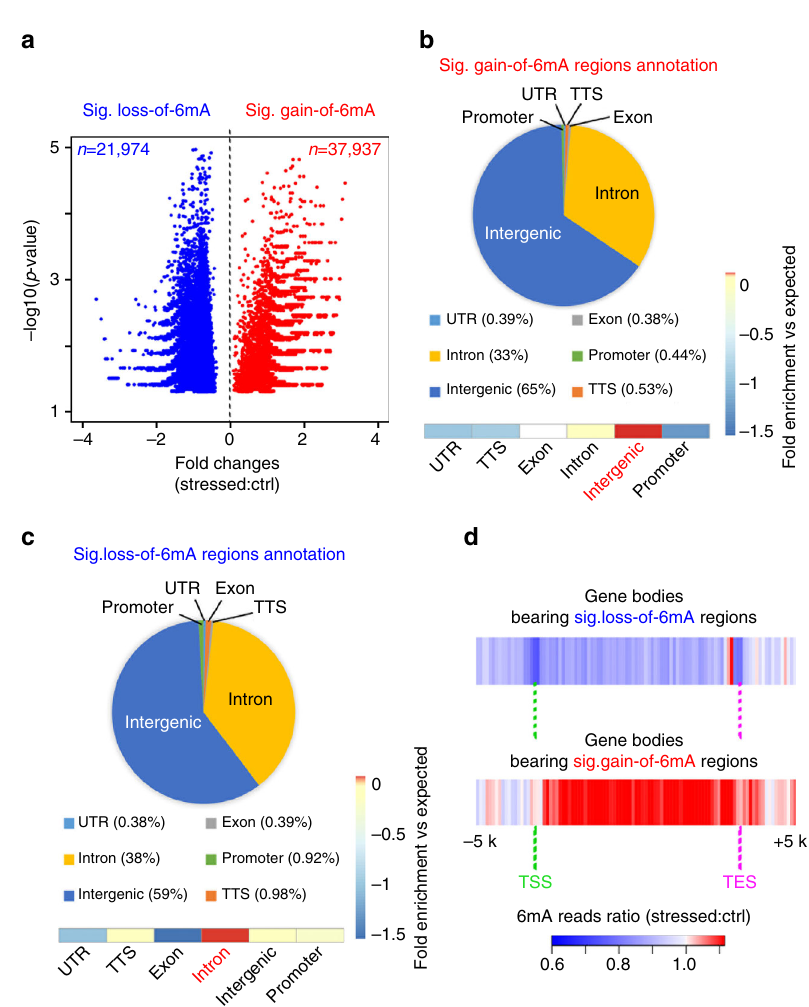
Fig. 2 Genome-wide 6mA pro fi ling in PFC reveals dynamic changes in 6mA on intragenic regions in response to stress. a Volcano plot illustrated the signi fi cant gain- and loss-of-6mA regions upon stress. Each dot represents 500-bp binned mouse genome containing signi fi cant 6mA reads differences by pair-wise replicate comparison. Fold changes in 6mA reads (Stressed:Control) are indicated on the x -axis, and – log10( p -value) of each bin are indicated on the y- axis. 37,937 signi fi cant gain-of-6mA regions and 21,974 loss-of-6mA regions are highlighted in red and blue, respectively. b , c Genomic annotation of signi fi cant gain- or loss-of-6mA demonstrate their percentage of genomic feature association and enrichment vs. expected values. Dynamic 6mA changes upon stress predominantly occurred on introns and intergenic regions. Gain-of-6mA regions were mostly enriched in intergenic regions over expected value whereas loss-of-6mA enriched in introns over expected values (Heatmap view, highlighted in red). d Average fold change between 6mA normalized reads (stressed vs. control) were calculated in gene bodies bearing loss- or gain-of 6mA regions upon stress, respectively, plus 5 kb upstream and downstream fl anking regions. Average fold change was plotted in Heatmap view. Red plots (fold change > 1) indicate overall gain of 6mA upon stress whereas blue plots (fold change < 1) indicate loss of